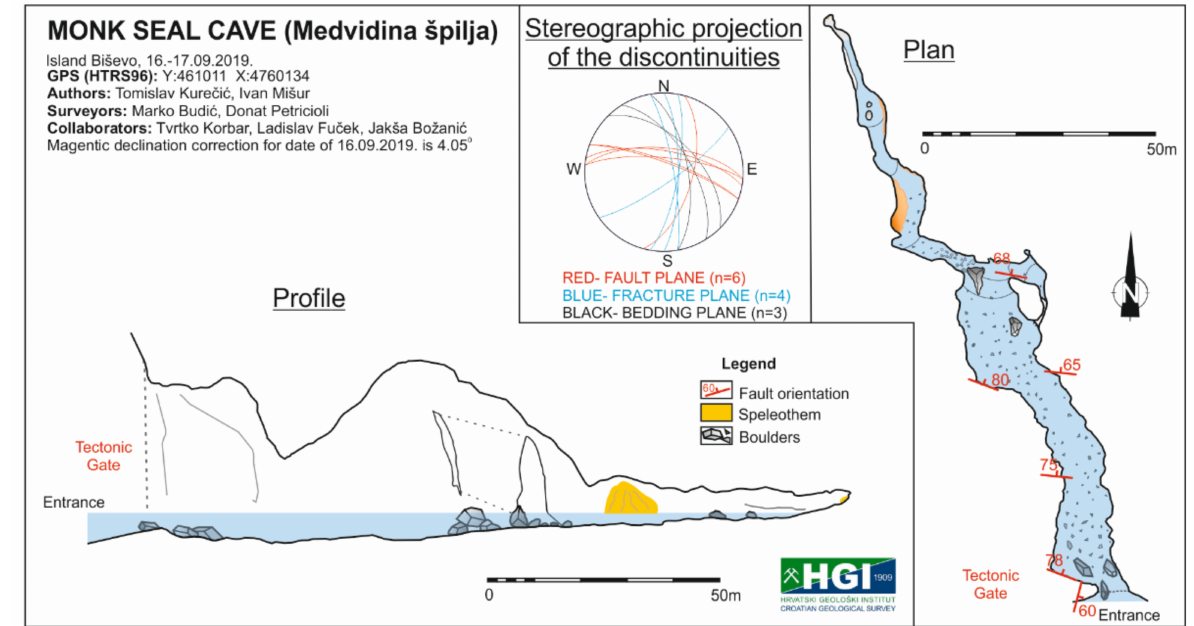
Figure 6. Plan and profile of the Monk Seal Cave (Medvidina špilja) (cave symbols according to [23,24]), with marked orientations of the bedding and fault planes. Stereographic projection (top centre) of all measured discontinuities on the surfaces and in the cave (lower-hemisphere